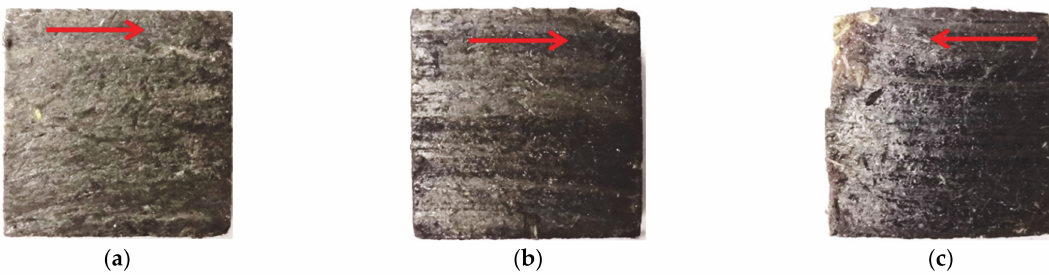
Figure 19. Surface morphologies of brake shoe specimens in cases of distinct braking times (the red arrow represents the sliding direction of the brake disc). ( a ) t = 30 s; ( b ) t = 60 s; ( c ) t = 120 s.